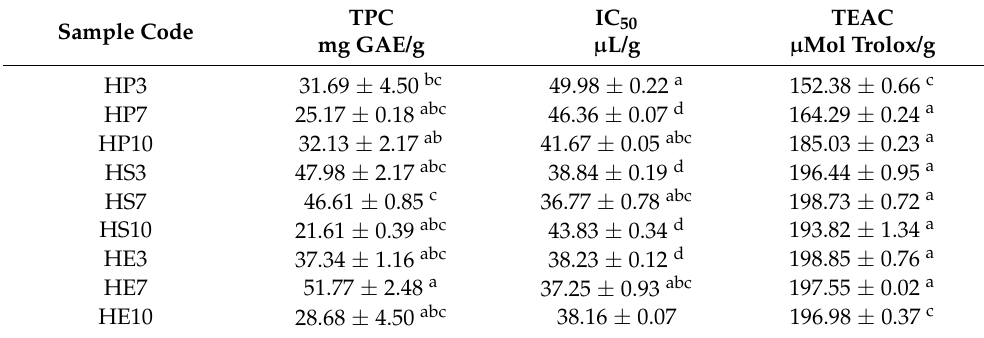
Table 3. The total phenolic compounds (TPC) and antioxidant activity (IC 50 and TEAC) of the hydrocolloids were obtained from mango ( Mangifera indica ) var. hilaza. at different pH. TPC IC 50 TEAC Sample Code µ L/g µ Mol Trolox/g mg GAE/g HP3 31.69 ± 4.50 bc 25.17 ± 0.18